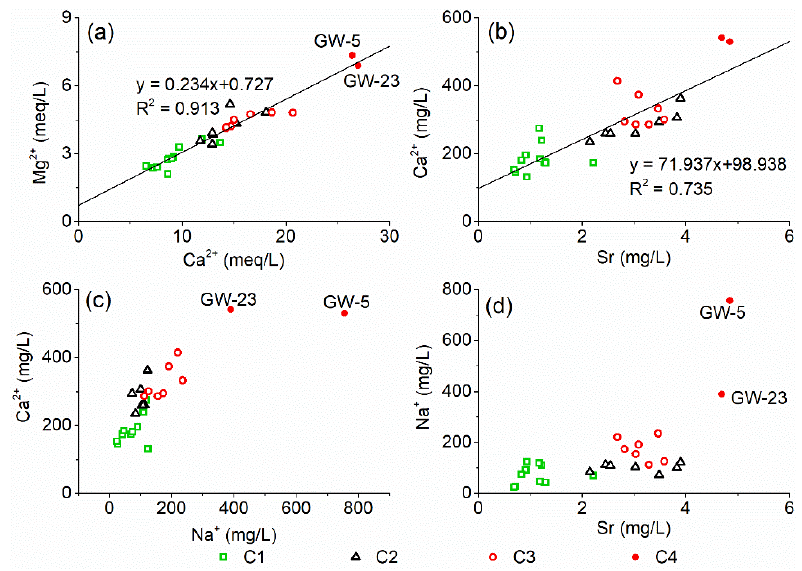
Figure 5. The relationship between the concentrations of Ca 2+ , Mg 2+ , Sr and Na + in groundwater in the study area.